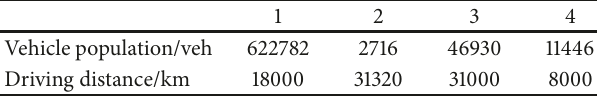
Table 11: Annual average driving distance and population. 1 Vehicle population/veh 622782 2716 46930 11446 Driving distance/km 18000 31320 31000 8000 Data from 2015 Statistical Yearbook of Zibo Transportation Administration Bureau